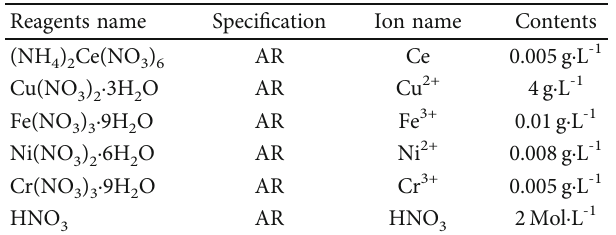
Figure 1: Extraction fl ow diagram of mixer-settler. a: Automatic collector; b: mixer-settler; c: constant current injection pump; d: feed liquid tank; e: extracted liquid tank; f: extraction solvent tank. Table 1: Contents of extract liquid containing other metal